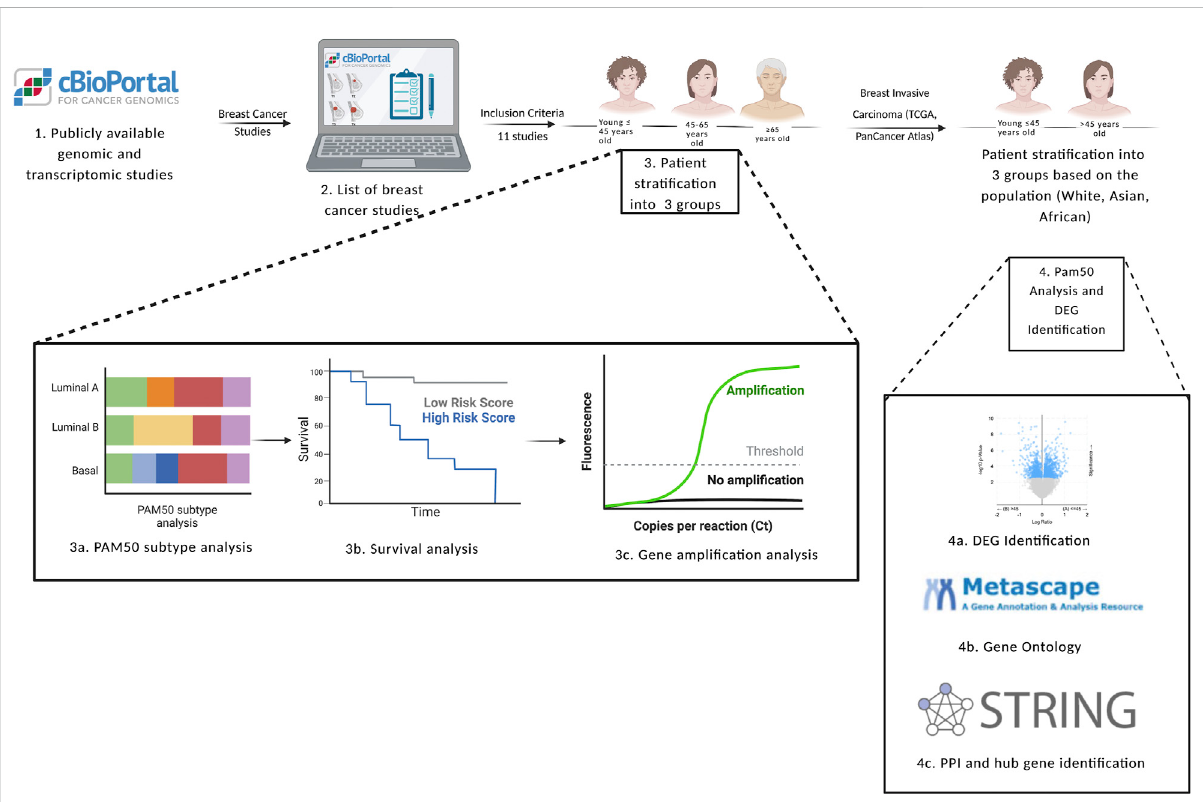
FIGURE 2 Flowchart diagram of the inclusion and exclusion criteria used in the study, in addition to the methods used to achieve the aims of the study. DEG: differentially expressed genes, PAM50: prediction analysis of microarray 50. Created with